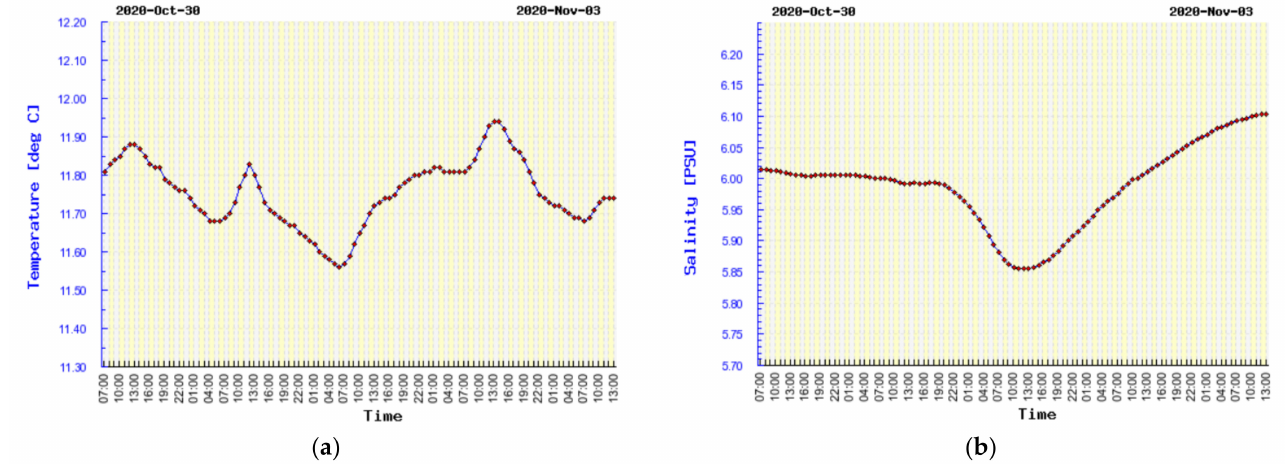
Figure 7. Temperature ( a ) and salinity ( b ) recorded in the station in Gda´nsk Northern Port for measurements in the Martwa Wisła River.